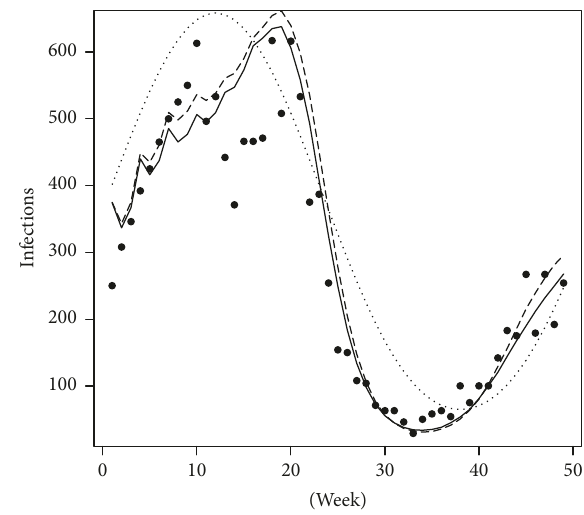
Figure 8: Reported cases of chickenpox from week 4 to week 52, 2012 (solid points), and point forecasts obtained with the Bayesian stochastic SEIR model in discrete time proposed in this paper (solid lined), the stochastic model in discrete time with a deterministic seasonal transmission rate (dashed line) and the deterministic continuous-time model with a seasonal transmission rate and heterogeneous mixing (dotted